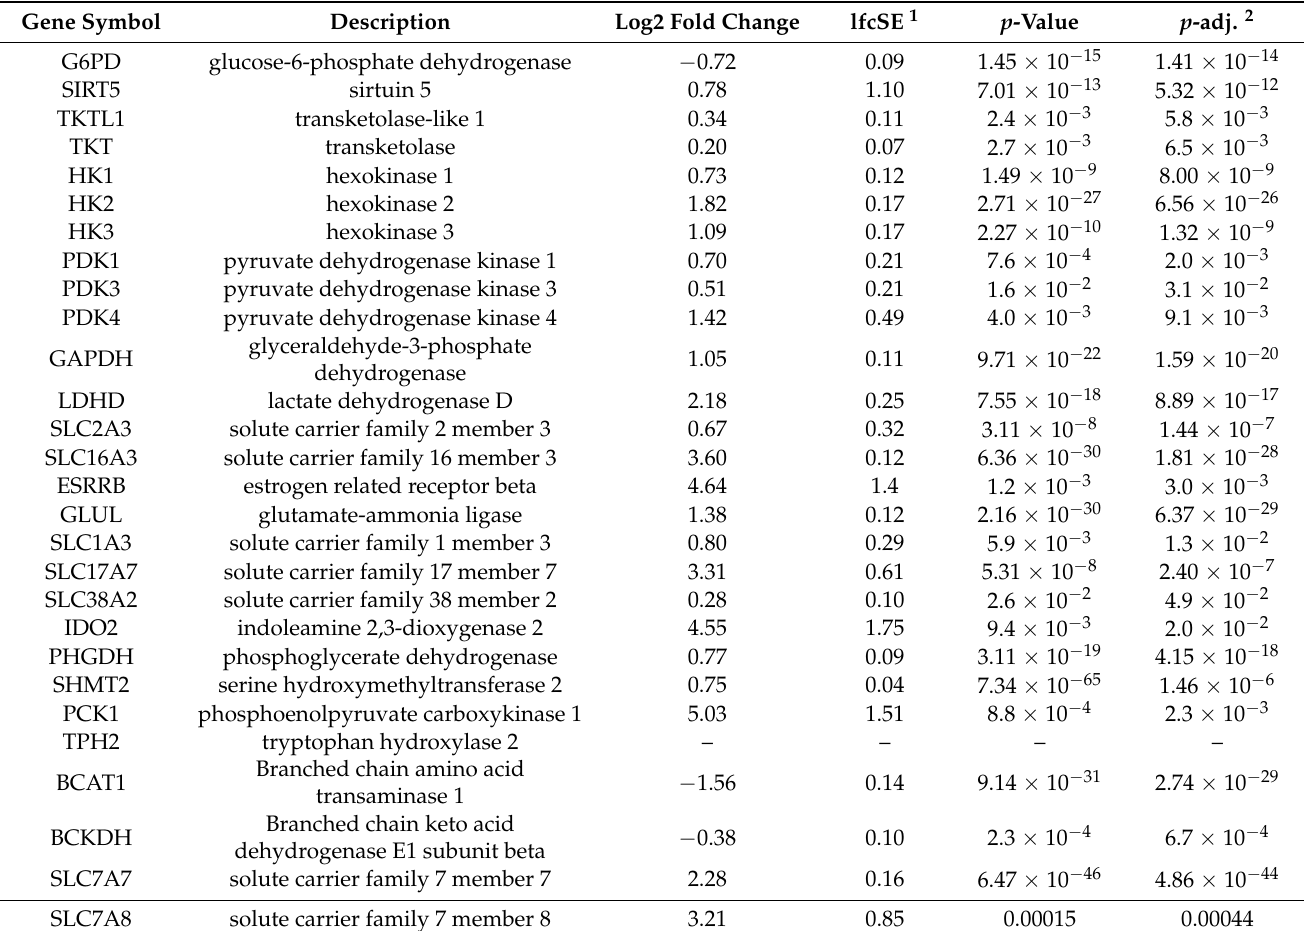
Table A1. Differential gene expression comparing THP1 WT cells in hypoxia (n = 3) versus normoxia (n =